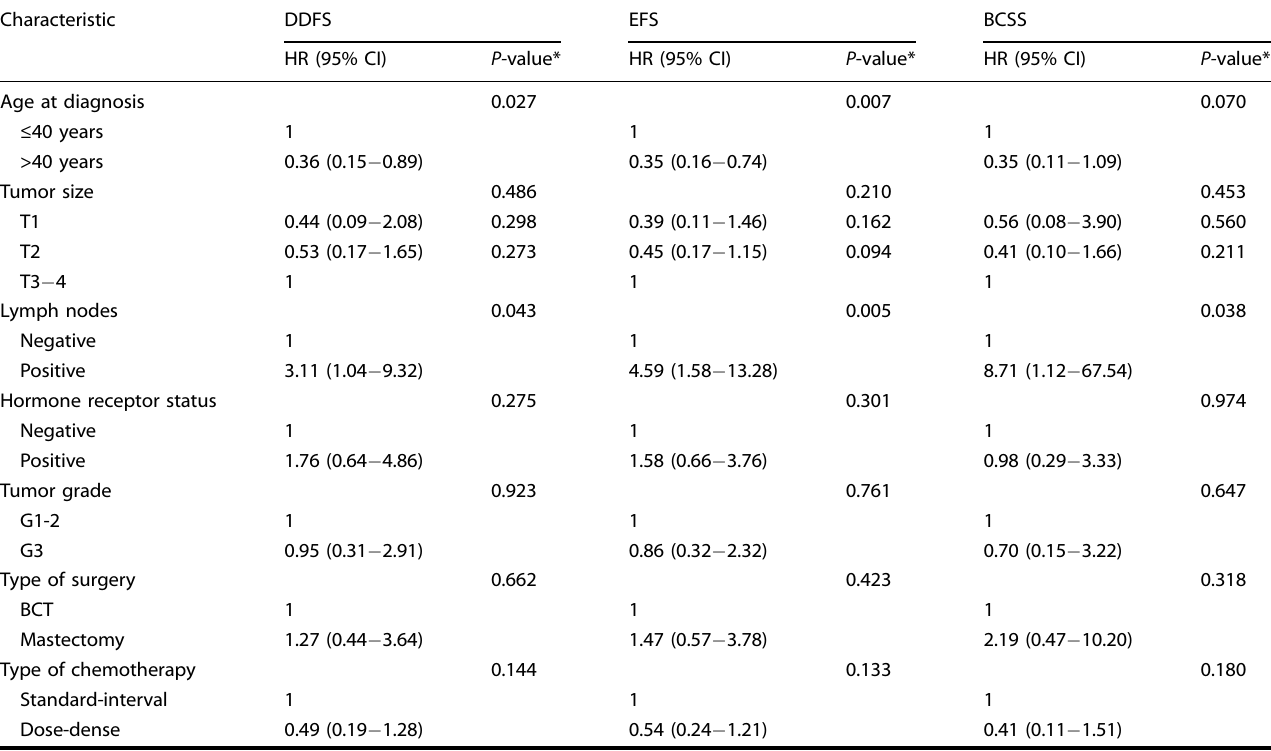
Table 5. Multivariate analyses for the effect of clinicopathologic characteristics and neoadjuvant treatment regimen on survival in the entire cohort.